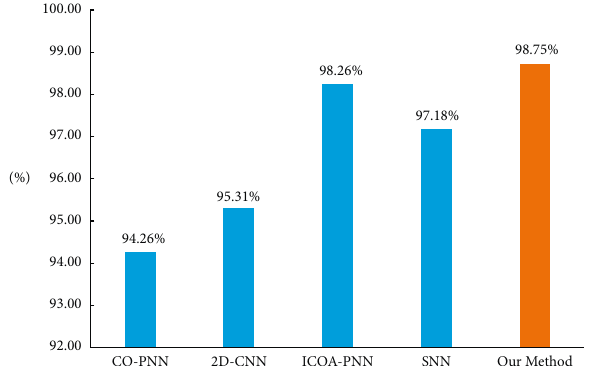
Figure 10: Comparison between our classifier and several other